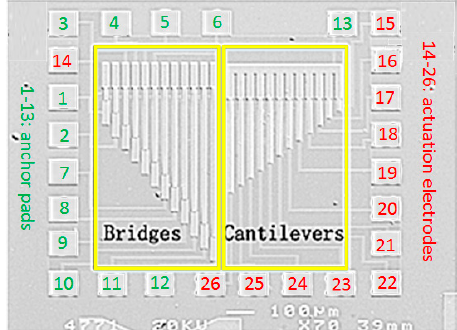
Figure 3. Processing steps of GaAs MMIC-based MEMS beams: the processing sequence is listed in the order of blue arrows.